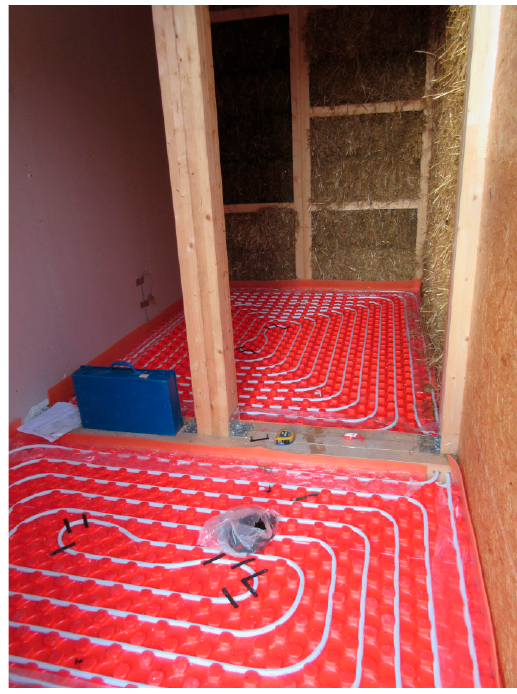
Figure 2. The room before the screed laying.